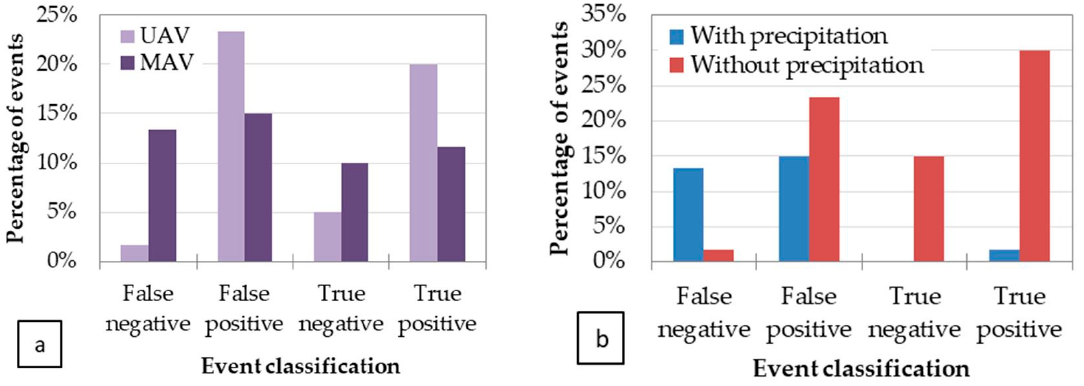
Figure 27. Relationship between event classification and ( a ) the platform used for the flights or ( b ) the occurrence of precipitation in the 10 days prior to the flights.